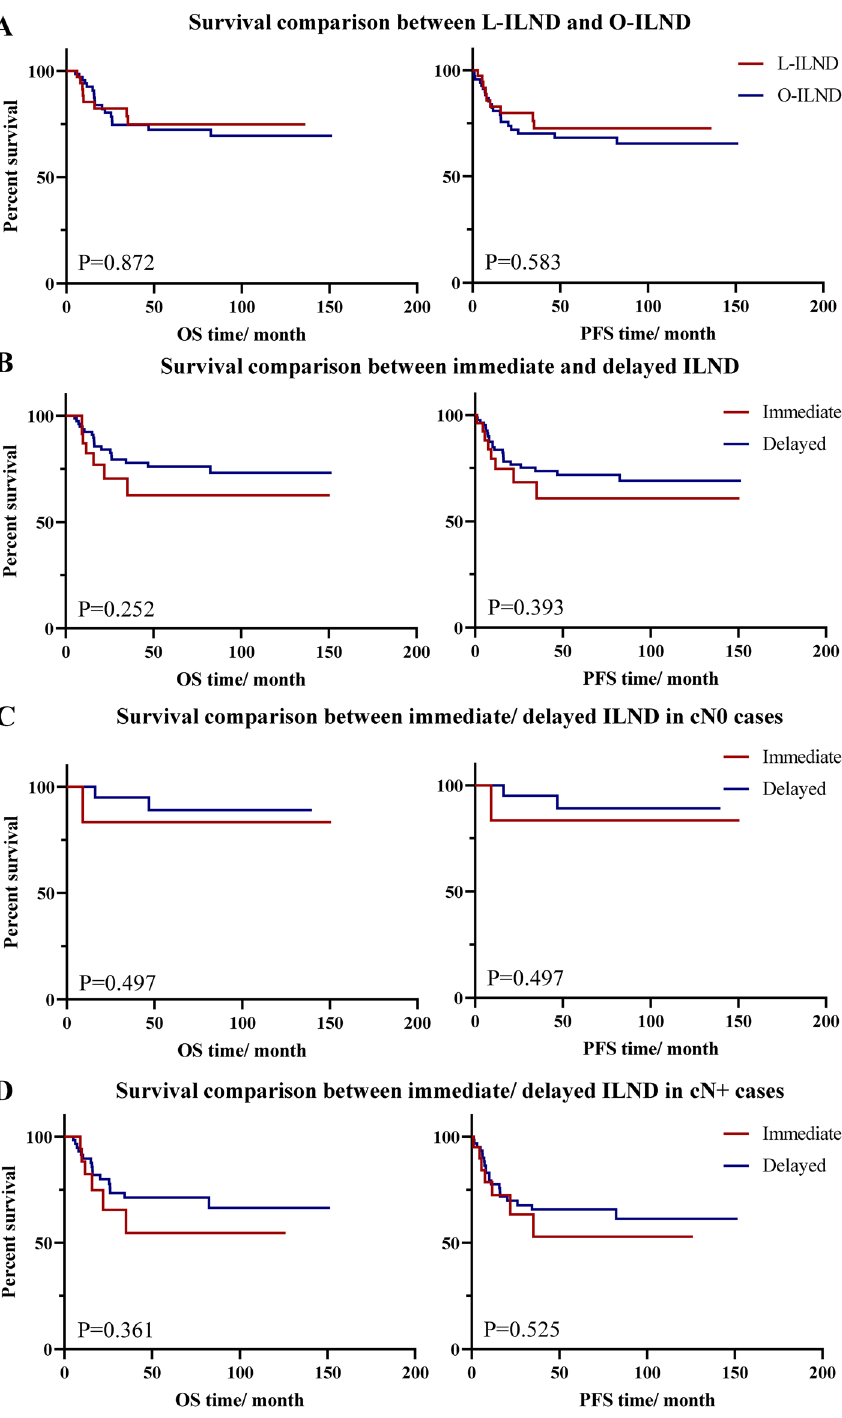
Figure 2. Survival comparison of different surgical subgroups. ( A ) Survival comparison between L-ILND and O-ILND; ( B ) Survival comparison between immediate and delayed ILND; ( C ) Survival comparison between immediate/ delayed ILND in cN0 cases; ( D ) Survival comparison between immediate/ delayed ILND in cN + cases. L-ILND: laparoscopic inguinal lymph node dissection; O-ILND: open inguinal lymph node dissection; cN0: clinical N stage 0; cN + : clinical N stage